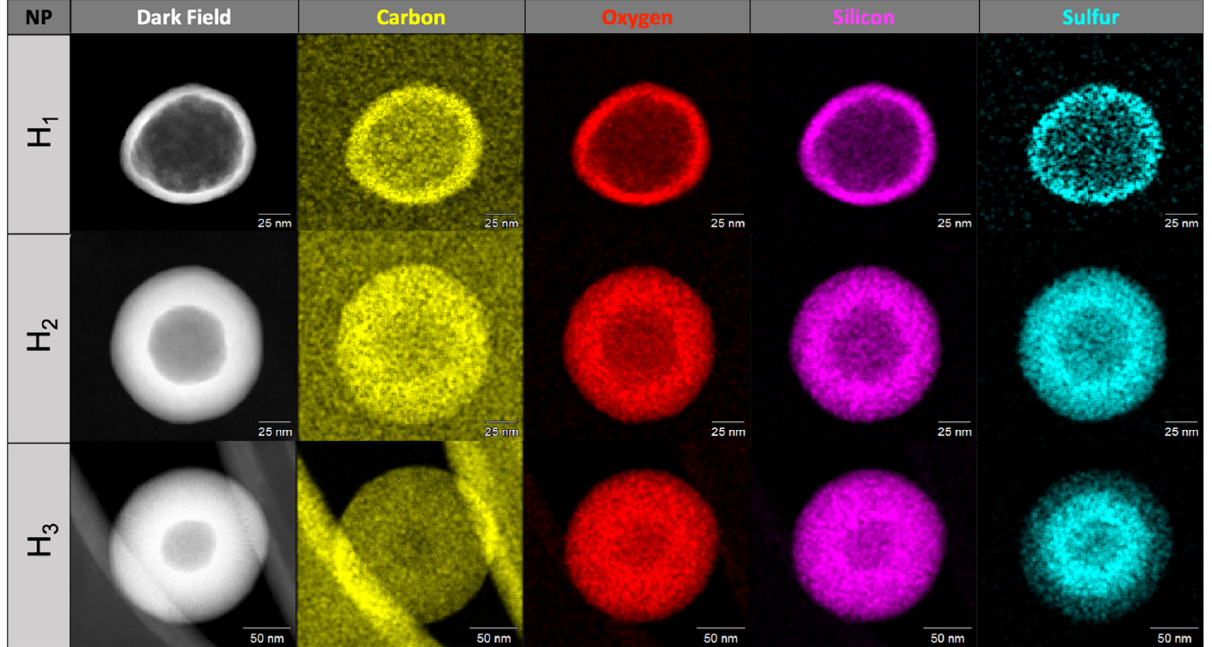
Figure 2. EDS maps for the fabricated layer-by-layer HMSNPs. Images demonstrate the homogeneous distribution of carbon, oxygen, silicon, and sulfur in the shell of these nanoparticles. The shell of each layer is visible in the sulfur map.